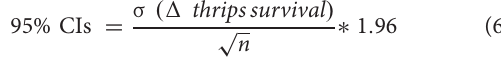
Table 3 ). All significant interaction effects, S X ∗ Y , were < 1 ( Figure 5 and Table 3 ). The interaction effects between the four PA N -oxides and CGA were not significantly different ( Figure 4B and Table 3 ). For senecionine N -oxide, both main effects, senecionine N -oxide and CGA concentration,